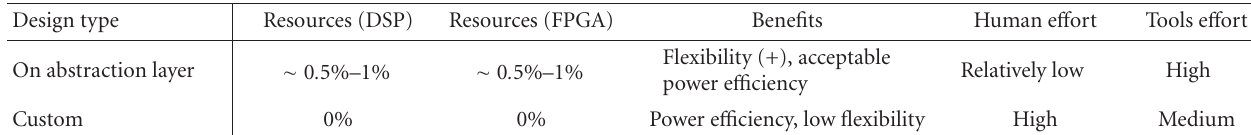
Table 1: Performance comparison and tools requirements.